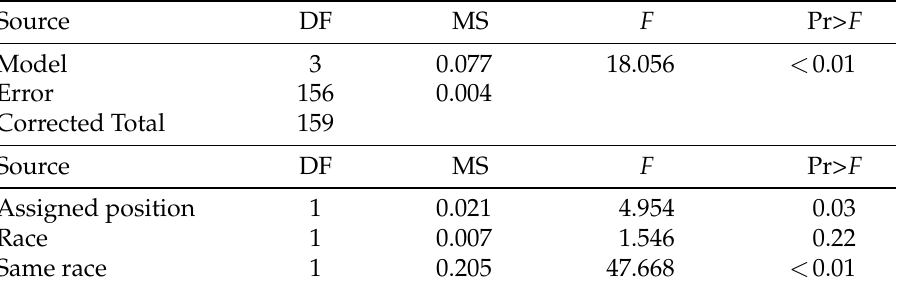
Table 6: Experiment 2 analysis of variance, role-taking accuracy by status, race, and race composition of the